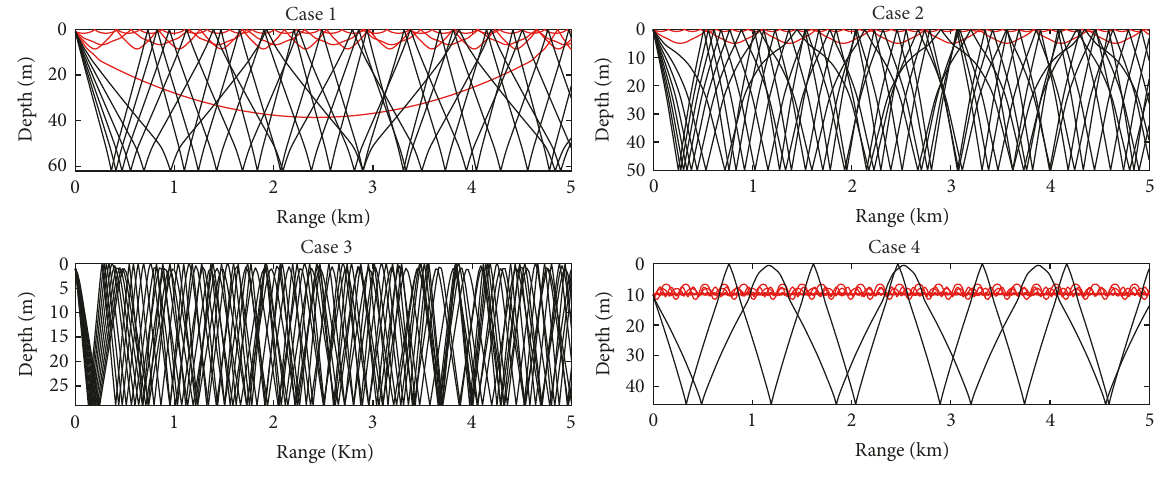
Figure 8: Acoustic ray for different